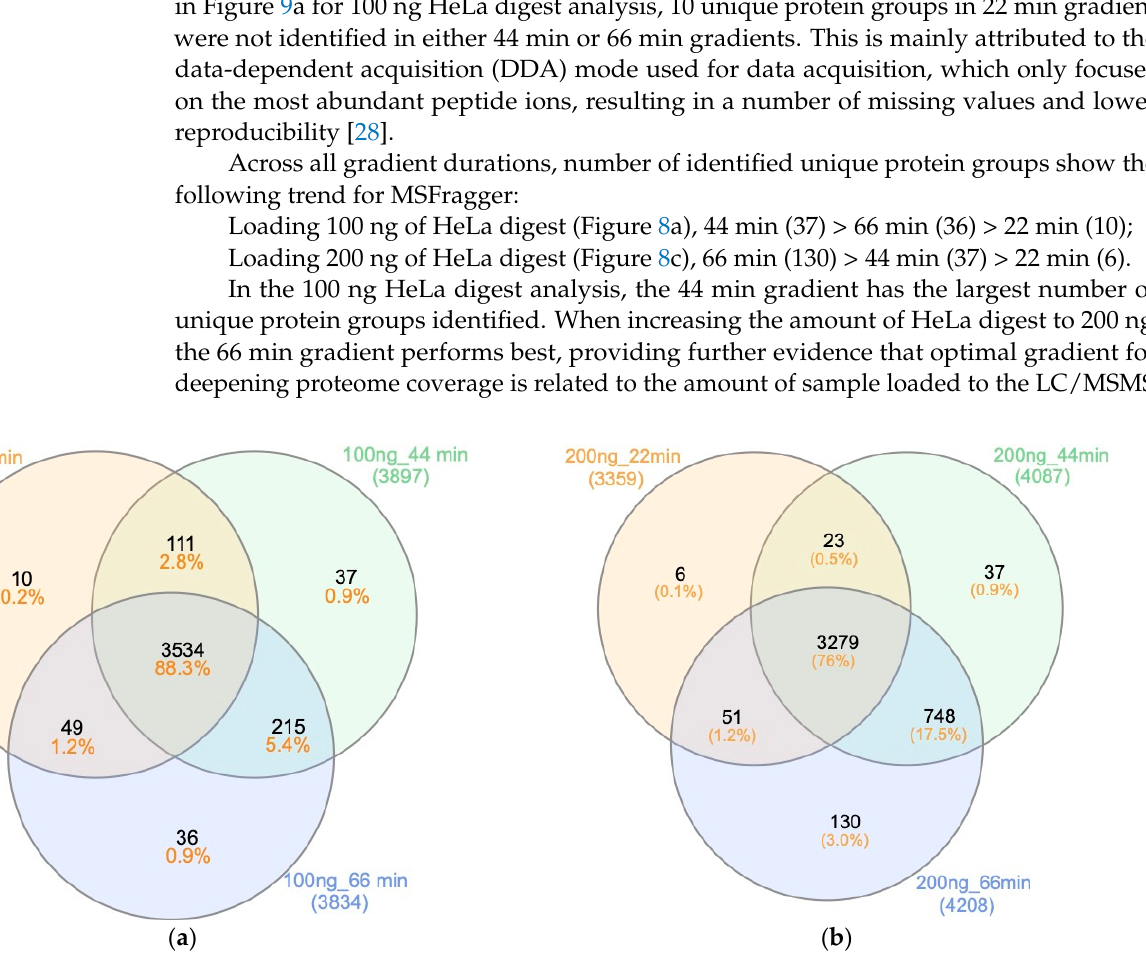
Figure 9. Proteome overlap between gradients. MSFragger-based Venn diagrams showing common identified protein groups between three gradient time courses and load amounts of HeLa digest ( a ) using 100 ng of HeLa digest; ( b ) using 200 ng of HeLa digest.